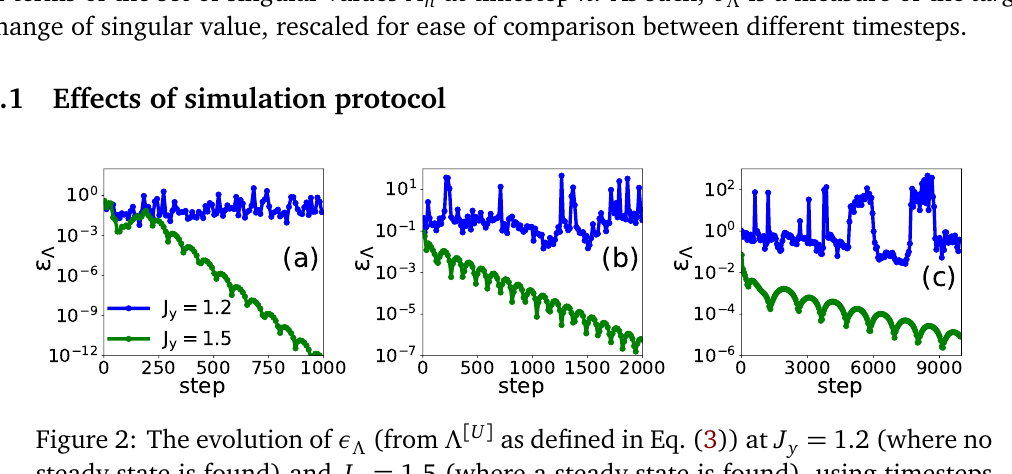
Figure 2: The evolution of ε Λ (from Λ [ U ] as defined in Eq. (3)) at J = 1.5 (where a steady state is found), using timesteps steady state is found) and J y (a) δ t = 10 − 1 , (b) δ t = 10 − 2 , (c) δ t = 10 − 3 . Energies given in units of κ =